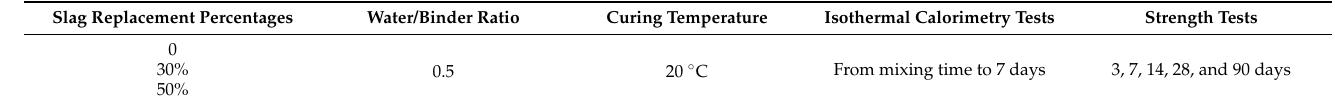
Table 3. Specimens and